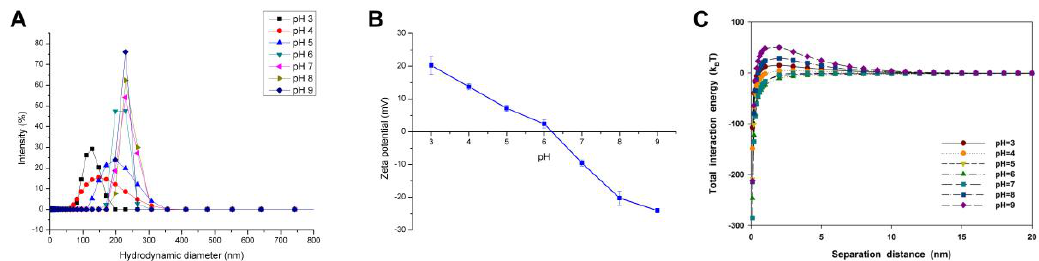
Figure 1. Size distribution ( A ); zeta potential ( B ); and calculated Derjaguin–Landau–Verwey–Overbeak Derjaguin–Landau–Verwey–Overbeak (DLVO) total interaction energy ( C ) of CuO nanoparticles (DLVO) total interaction energy ( C ) of CuO nanoparticles (NPs) (100 mg/L) in the aqueous solution (NPs) (100 mg/L) in the aqueous solution with different pH conditions and a constant ionic strength with different pH conditions and a constant ionic strength of 10 mM NaCl. The values of zeta potential of 10 mM NaCl. The values of zeta potential were given as mean ± SD of triplicate samples. were given as mean ± SD of triplicate